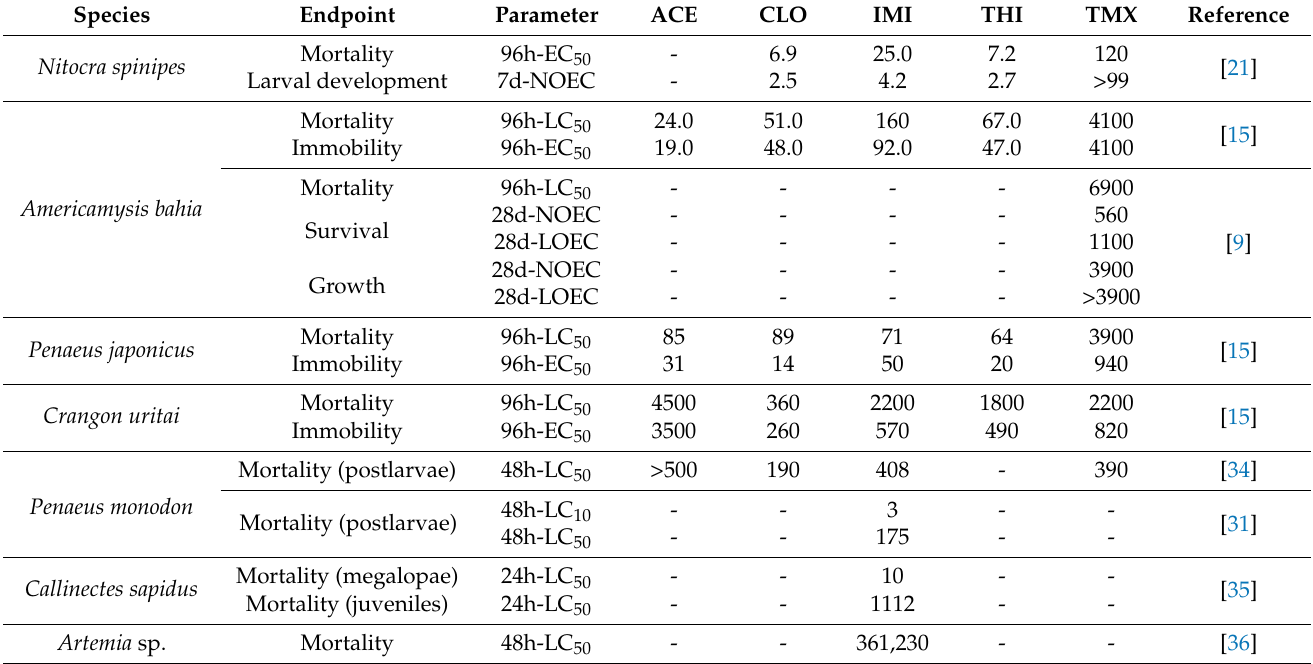
Table 3. Toxicity of NEOs towards marine and brackish crustaceans. All data are reported in µ g L − 1 . NOEC, no observed effect concentration; LOEC, lowest observed effect